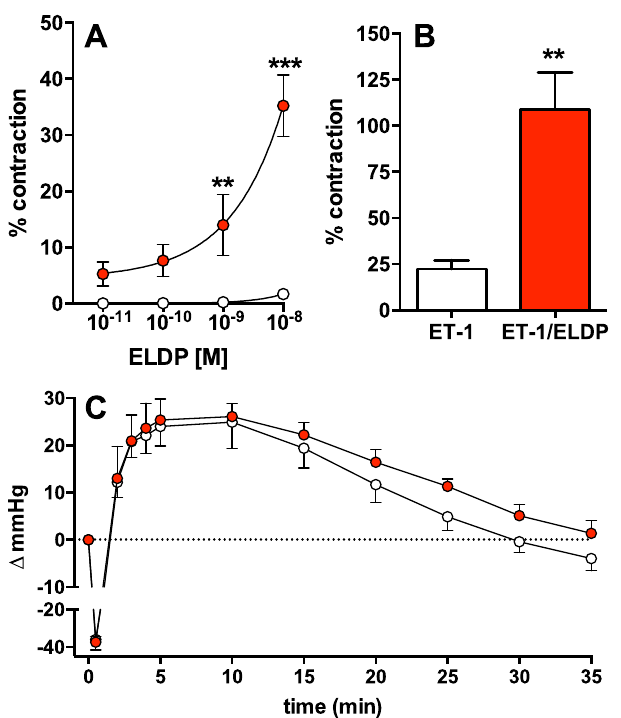
Figure 7. Cardiovascular effects of ELDP. ( A ) and ( B ) isolated rat mesenteric resistance arteries; ( A ) effect of ELDP [162-amide] alone (white circles, n = 12) or after pre-treatment with ET-1 (1–3 × 10 − 9 M) to induce ≈ 10% vasoconstriction relative to the maximal response to phenylephrine (10 µ M) (red circles, n = 7) ( ** P < 0.01, *** P < 0.001, compared to the same concentration without ET-1; 1 × 10 − 8 M ELDP [162-amide] with ET-1 caused a significantly greater vasoconstriction than all other concentrations of ELDP [162-amide] with ET-1, P < 0.001; 2-way ANOVA with Bonferroni correction). ( B ) vasoconstrictor response to ET-1 (1 × 10 − 9 M) alone (n = 8) or after pre-incubation with ELDP [162-amide] (10 × 10 − 9 M, n = 10); P < 0.002; Student’s t-test. ( C ) Change in mean arterial blood pressure in anaesthetised rats following ET-1 (0.3 nmol/kg, i.v .) alone (white circles, n = 6) or 15 min after ELDP (3 nmol/kg i.v .) (red circles, n = 6). Following ELDP the response to ET-1 was significantly greater; P < 0.02, by 2-way ANOVA. Results are mean ±